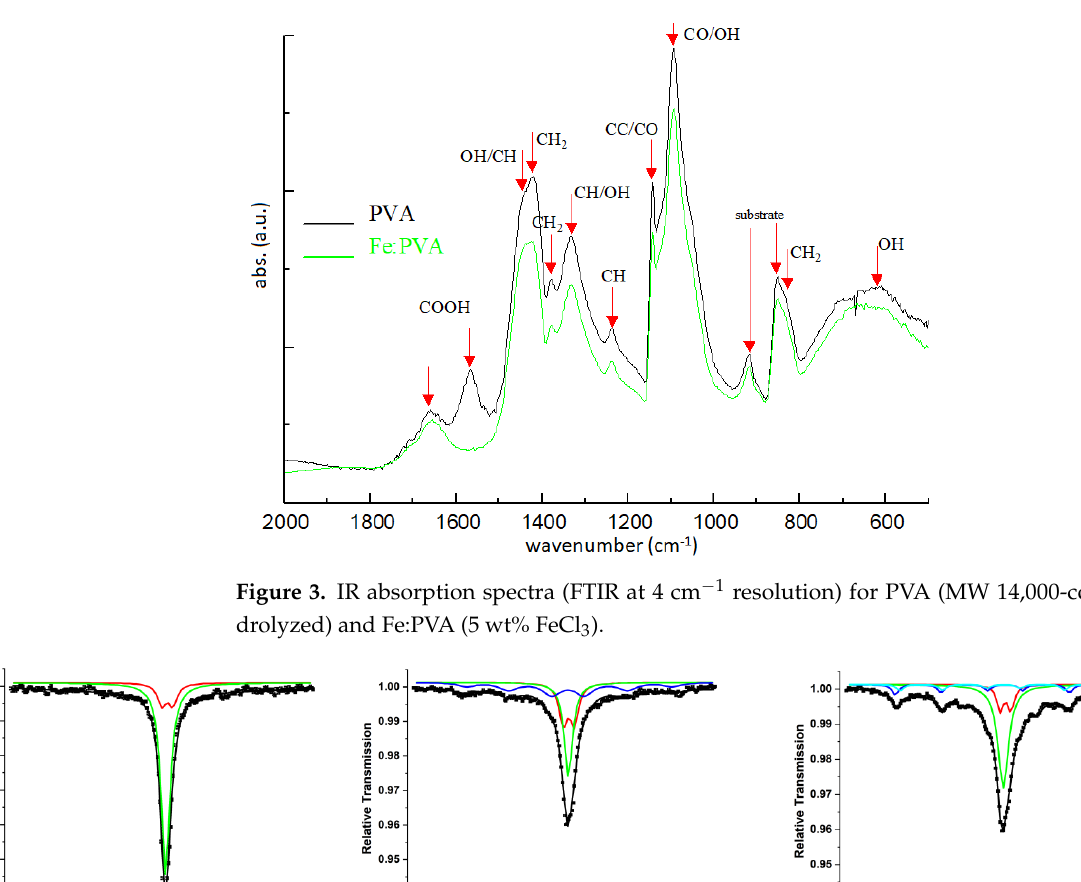
Figure 3. IR absorption spectra (FTIR at 4 cm −1 resolution) for PVA (MW 14,000-completely hydro- lyzed) and Fe:PVA (5 wt% FeCl 3 ).